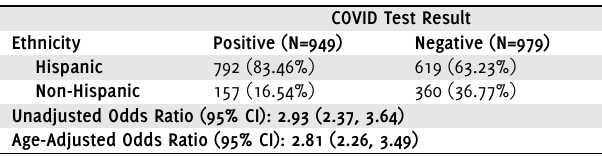
COVID Test Result